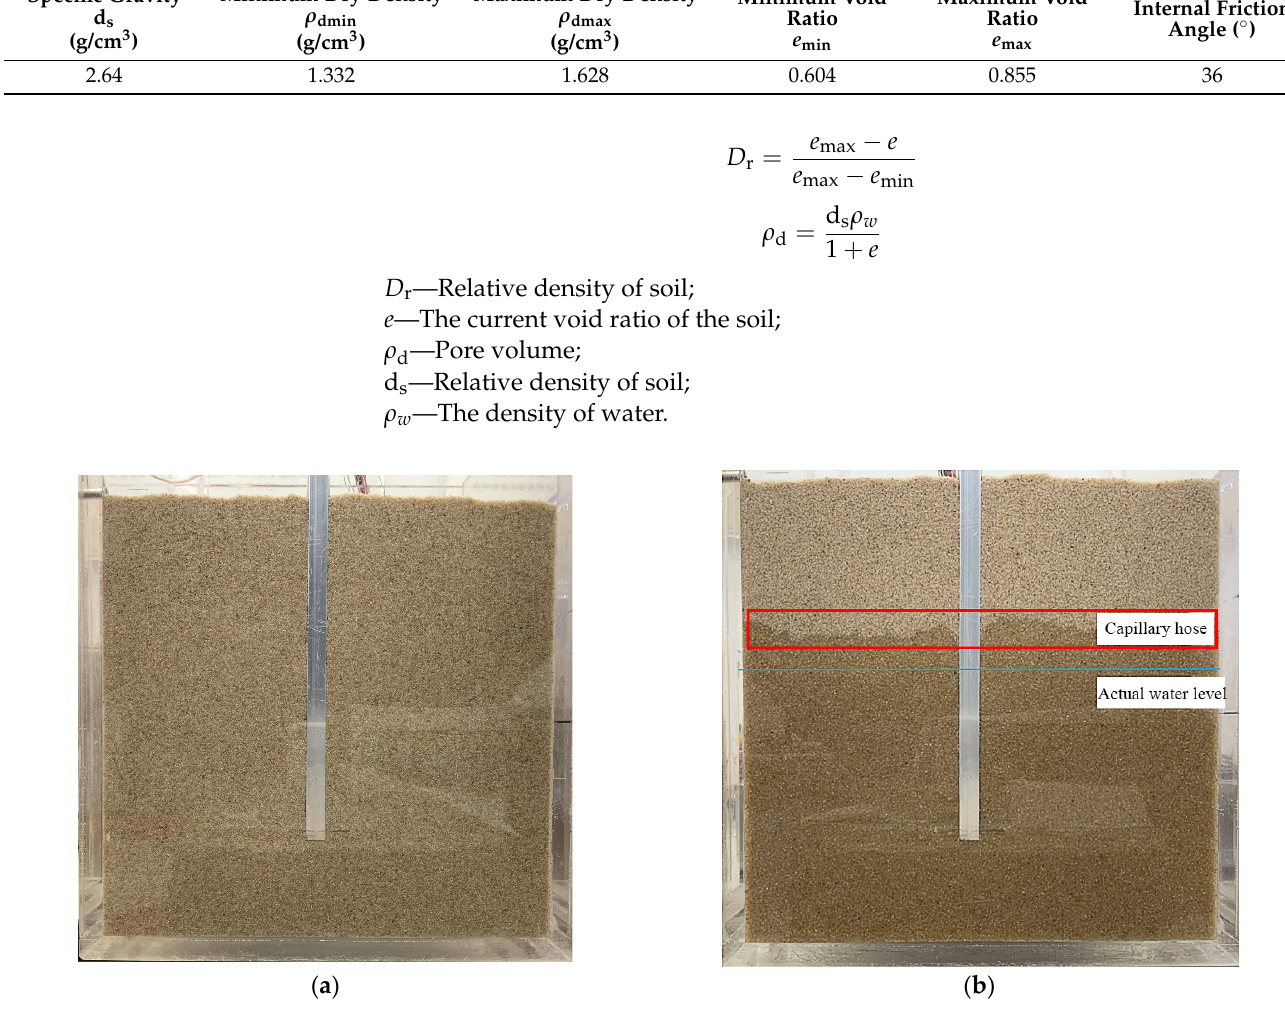
Figure 3. The sand packed in the box. ( a ) Packed sand. ( b ) Packed sand with groundwater.